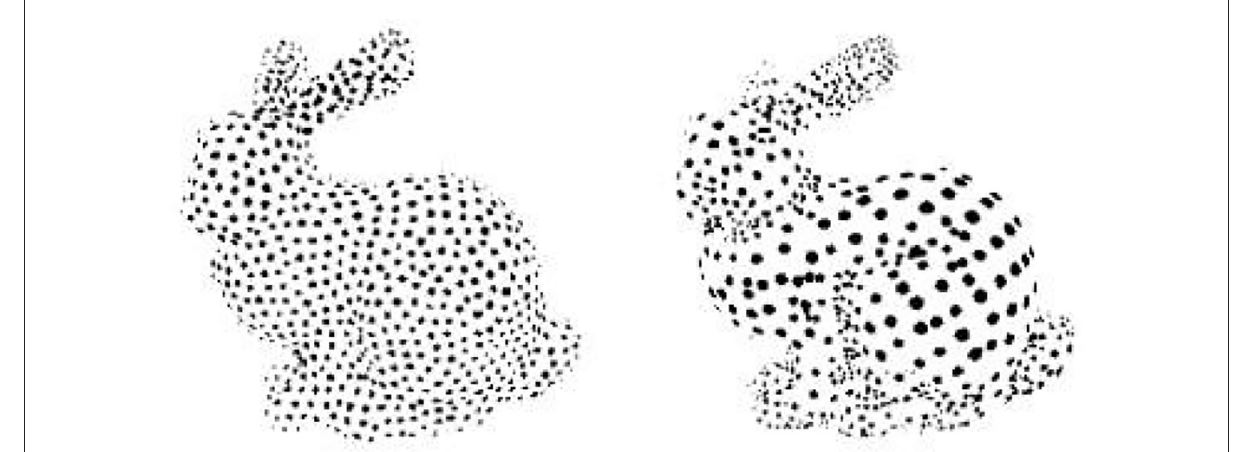
FIGURE1 Clustering method instance.